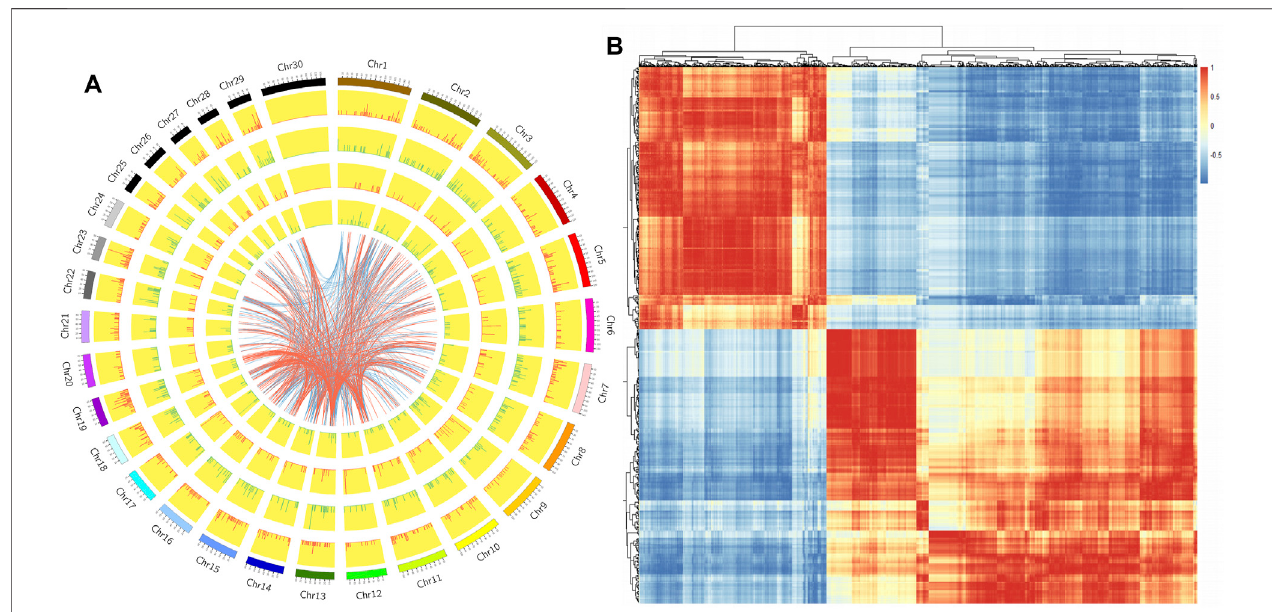
FIGURE 4 | (A) . Circos map of differentially expressed genes and LncRNAs on cattle chromosomes. The outer ring is the diagram of autosomal distribution of the species;the fi rstandsecondcirclesshowthedistributionofdifferentiallyexpressedgenesonchromosomes,withredlinesindicatingup-regulation,greenlinesindicating down-regulation, and the higher the column, the more differentially expressed genes in this region; the fourth and fi fth circles show the distribution of LncRNAs on chromosomes, with the same expression pattern as genes. The internal lines indicate the corresponding relationship between LncRNAs and genes coexpressed by TOP 500. (B) . The Pearson correlation coef fi cient heat map of differential LncRNAs and mRNAs: Red represents positive correlation and blue represents negative correlation.